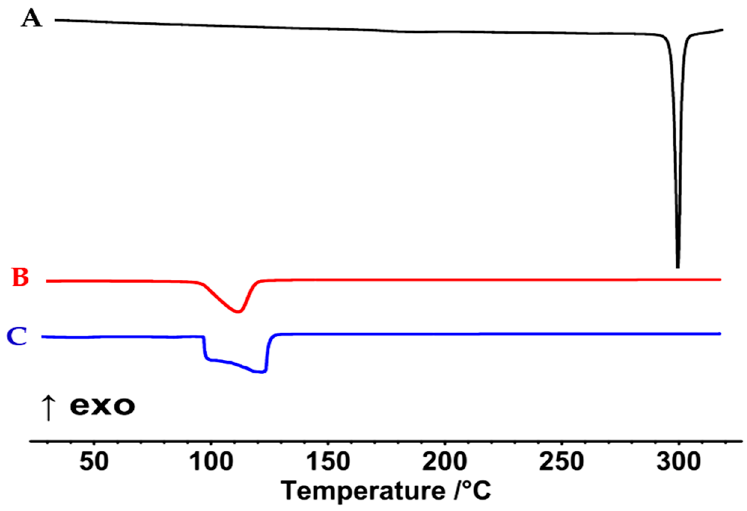
Figure 6. DSC thermograms of the unprocessed tadalafil (A), the nano ‐ jelly formulation (B) and the corresponding blank formulation (C).